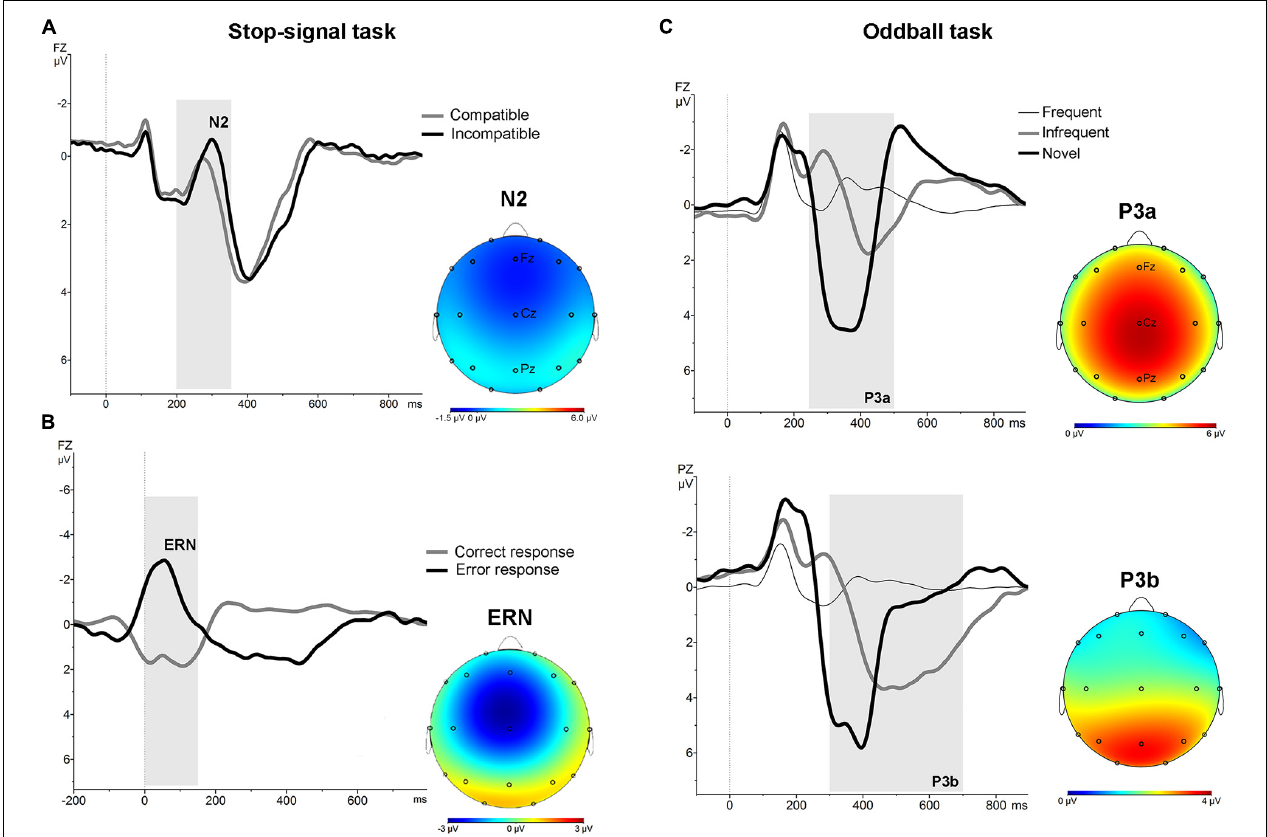
FIGURE 1 | Stimulus-locked and response-locked (ERN) grand average ERPs for the whole sample in the stop-signal task. (A) Stimulus-locked grand average ERP at Fz electrode for compatible (grey line) and incompatible (black line) trials. The N2 is identified as the negative deflection in the ERP appearing between 200 and 350 ms (grey area). The topographical map shows the increased frontocentral negativity for incompatible trials. (B) Response-locked grand average ERPs at Fz electrode for correct (grey line) and error (black line) responses. The ERN is identified as the negative deflection in the ERP appearing between 0 and 160 ms (grey area). The topographical map shows the frontal-central ERN. (C) ERPs associated with frequent, infrequent and novel stimuli in auditory oddball task. Grand average stimulus-locked ERPs at Fz and Pz electrodes for the whole sample. The P3a was identified as the most positive deflection in the ERP between 250 and 500 ms (grey area) post-stimulus in the novel trials. The P3b was identified as the most positive deflection in the ERP between 300 and 700 ms post-stimulus in the infrequent trials. The topographical map shows the P3a and